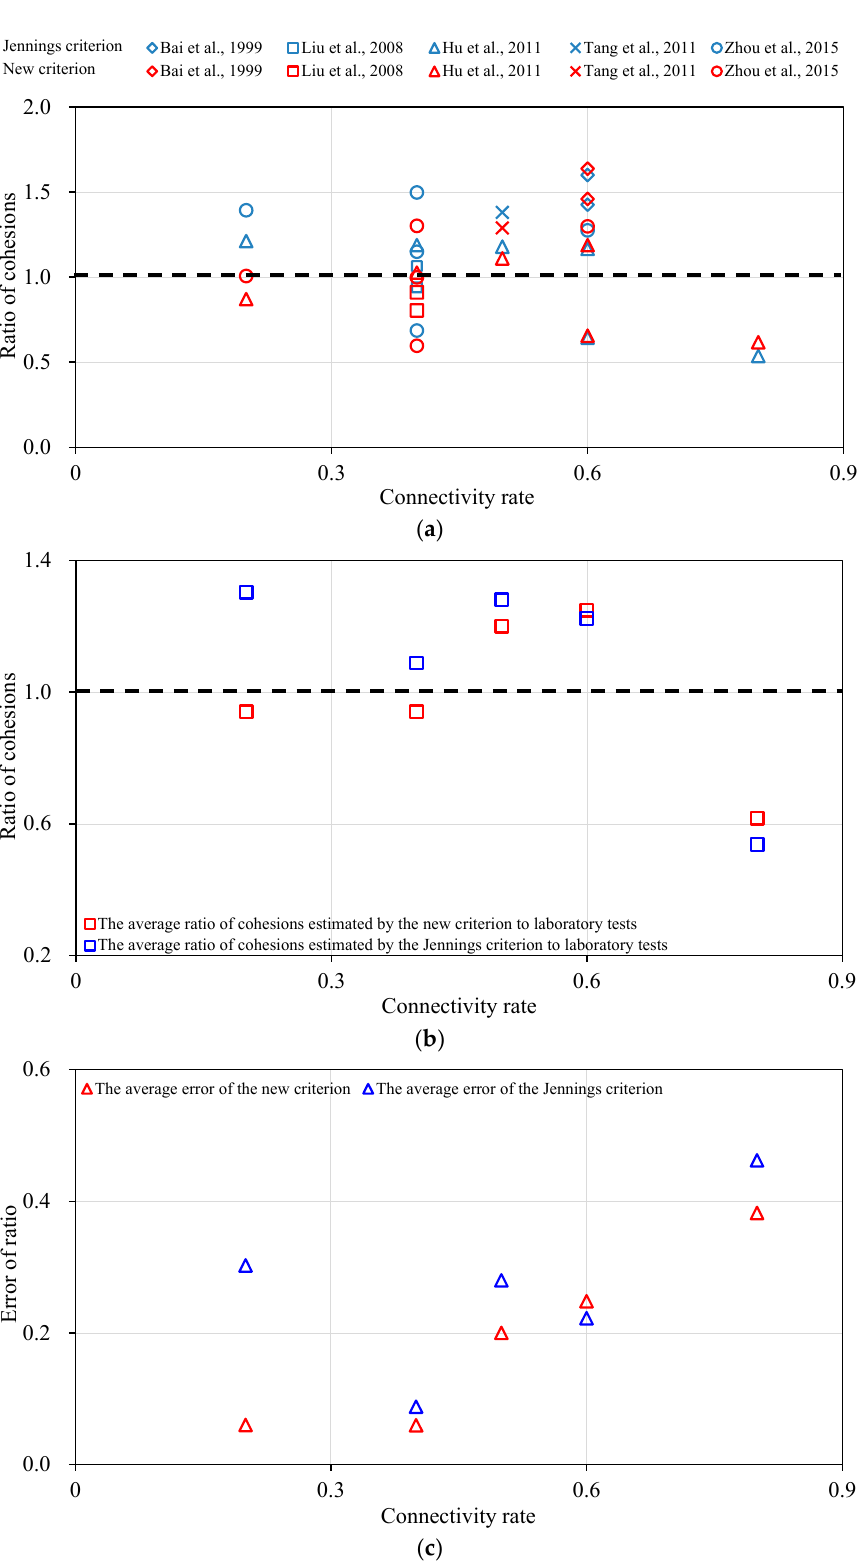
Figure 3. Comparison of the ratios of the estimated cohesions by the Jennings and new criterions to the test results of the cohesions with various connectivity rates. ( a ) The cohesion ratio with the connectivity rate; ( b ) The average cohesion ratio with the connectivity rate; ( c ) The error with the connectivity rate.